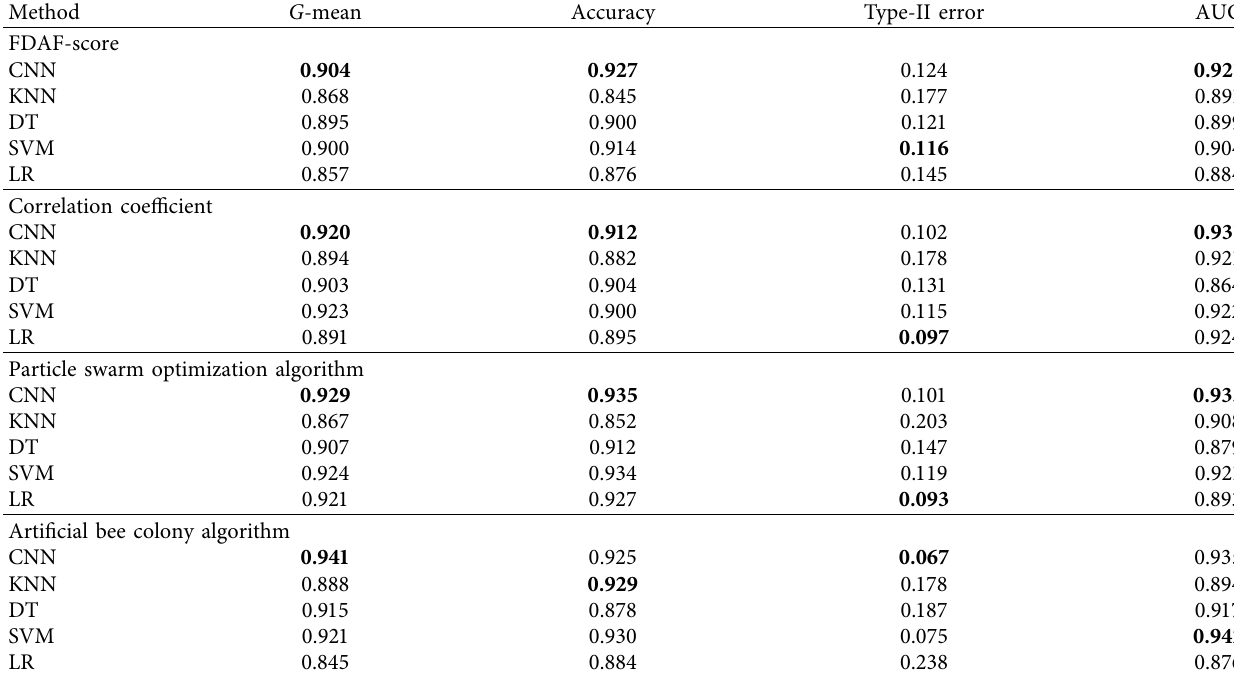
Table 13: The comparison experiments of feature selection methods on China